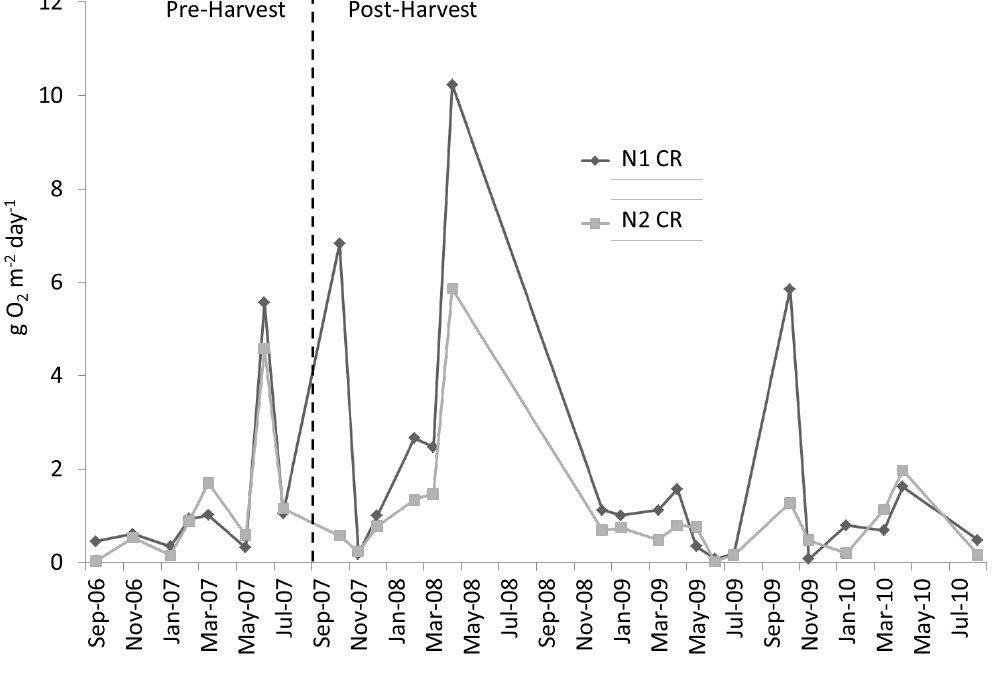
Figure 7. Time series of monthly averaged community respiration ( CR ; g O N1 and N2 over the study period. Harvest is indicated by the vertical, dashed